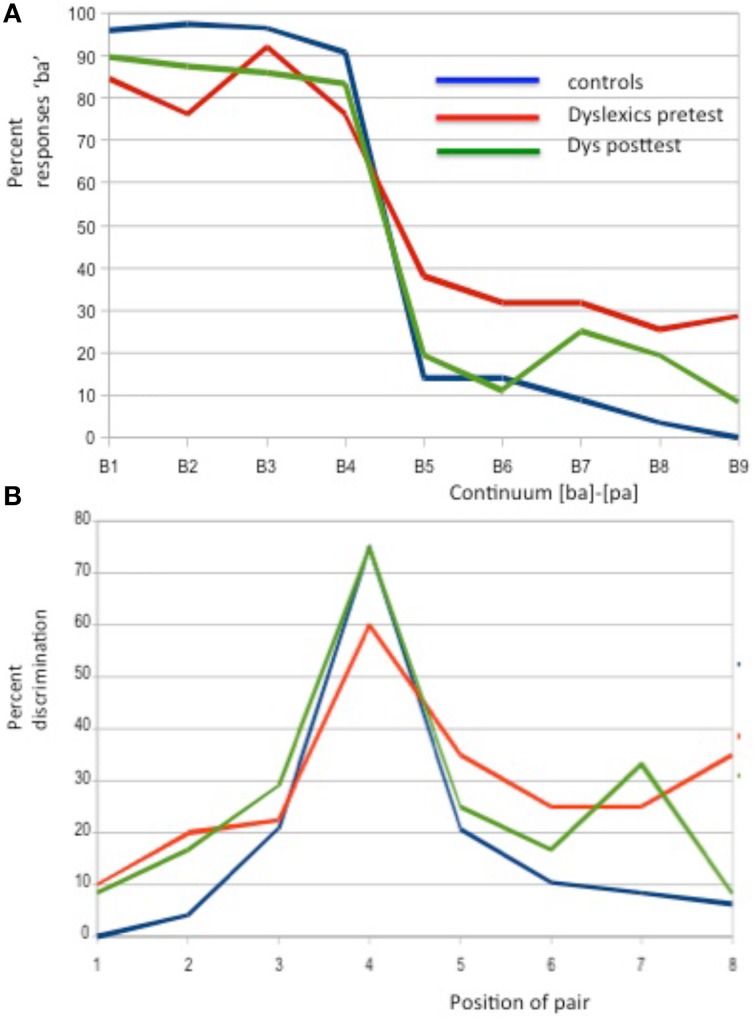
Categorical perception using a nine steps continuum between the syllables [ba] and [pa]. In the identification test (A) dyslexic children before CMT (red) showed less steep intercategorical boundary than normal readers (blue) but a “normalization,” specifically for B5 and B6 after CMT (green). In the discrimination task (B), dyslexics before CMT (red) seemed to differ from normal readers (blue) for items at or close to the inter-categorical border (median peak in the figure) but these differences vanished after CMT (green).